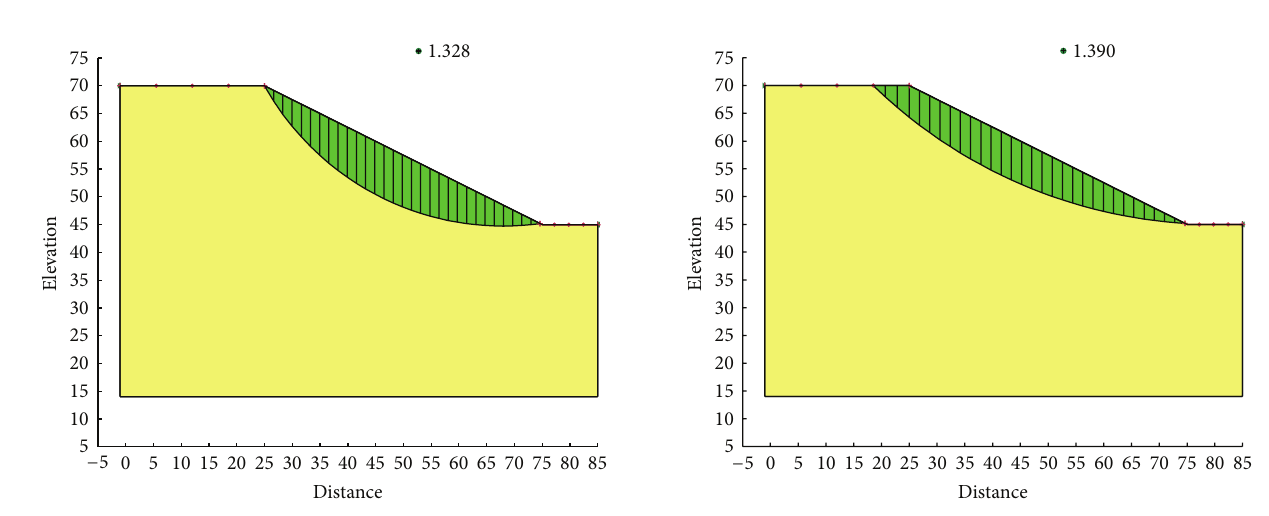
Figure 7: Critical failure surface with the Ordinary method. Figure 8: Critical failure surface with the Bishop